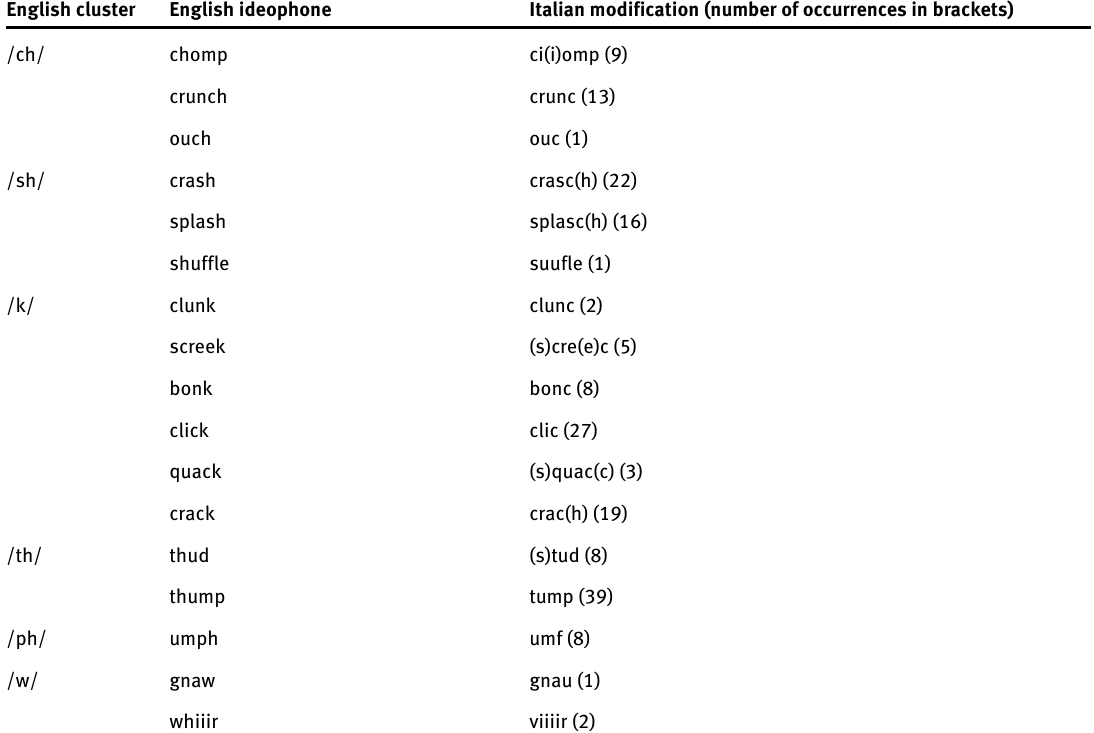
Table 6. Cases of consonantal